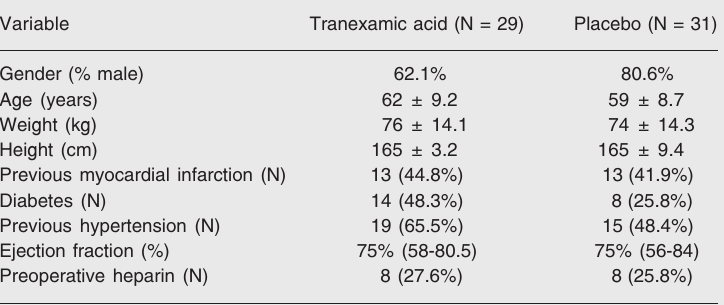
Table 1. Demographic and baseline characteristics of the patients studied.